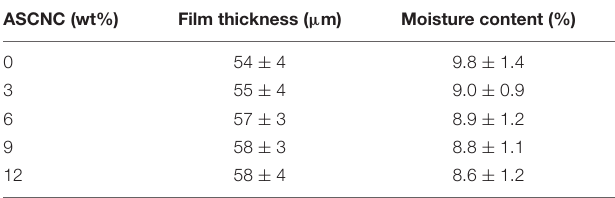
TABLE 1 | Basic properties of ASCNC-enhanced ASH/PVA composite films. ASCNC (wt%)